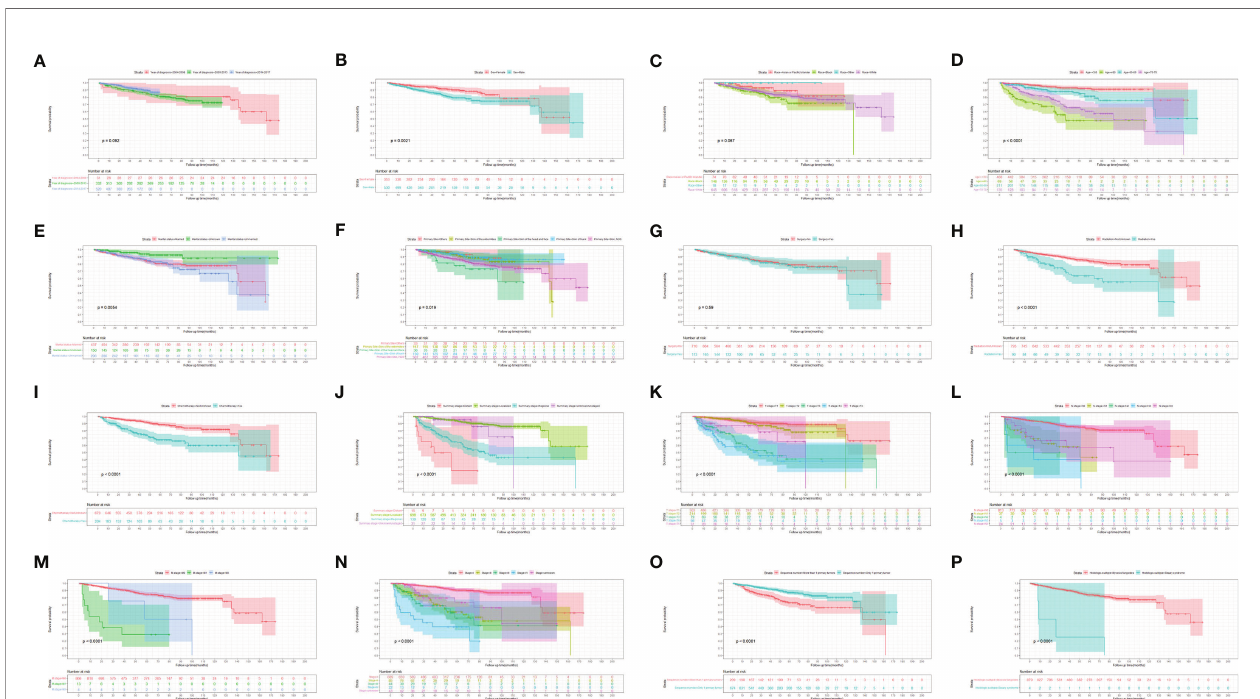
FIGURE 3 | Kaplan-Meier survival analysis of the effect of each independent predictor on OS in patients with HIV-associated CTCL. (A – P) The survival curves of year of diagnosis, sex, race, age, marital status, primary site, surgery, radiation, chemotherapy, summary stage, t stage, n stage, m stage, stage, sequence number, histologic subtype, respectively. OS, overall survival; HIV-associated CTCL, human immunode fi ciency virus associated cutaneous T-Cell